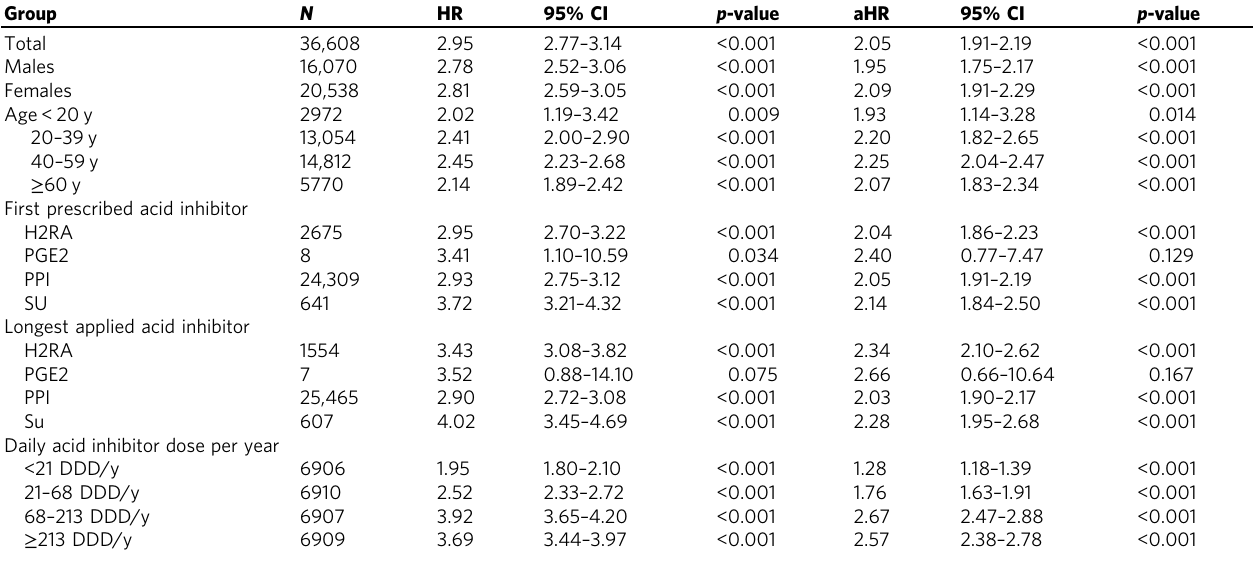
Table 3 Hazard ratios for prescription of anti-allergic drugs after prescription of gastric acid inhibitors or control medications Group